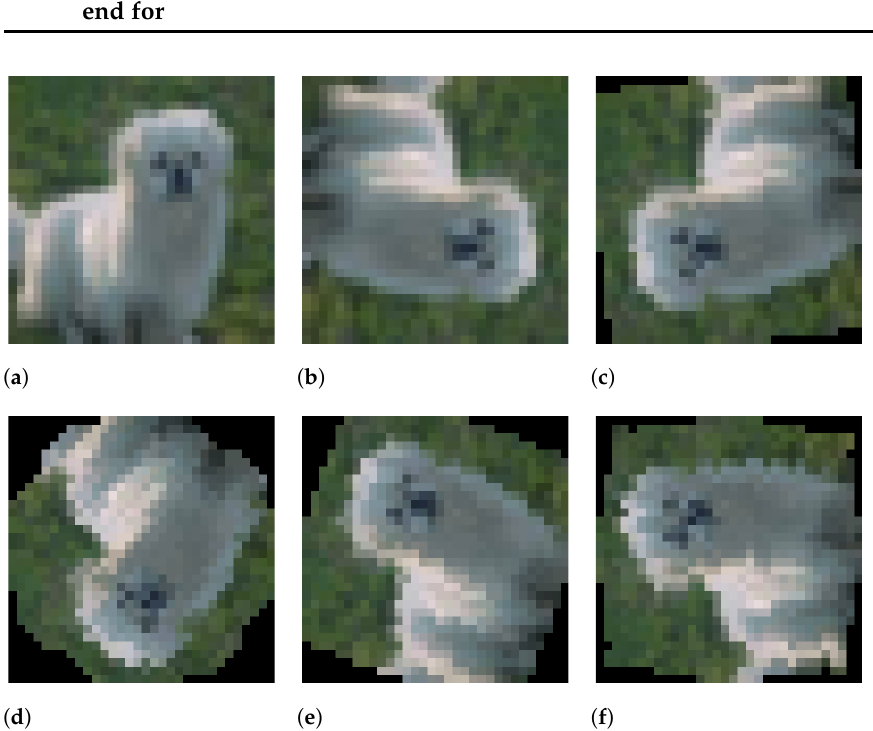
Figure 7. Examples of color images generated using templates after applying the various geomet- ric transformations. ( a ) Original image. ( b ) Vertical flip. ( c ) Horizontal flip + affine. ( d ) Rotation + affine. ( e ) Rotation + horizontal flip. ( f ) Rotation + horizontal flip +